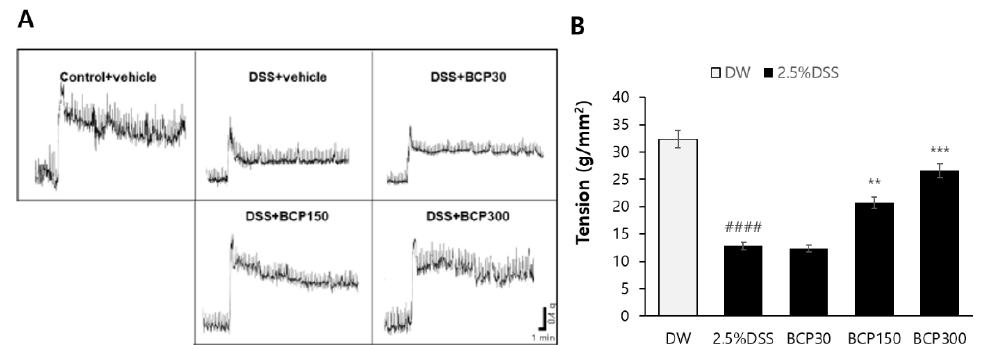
Figure 2. The effect of BCP on the changes of the inotropic contractile force in DSS-induced colitis model. After colon collection, the inotropic contractile force of the colon was measured to compare the effect of BCP on intestinal motility during colitis. Data are presented as mean ± SEM. Group comparisons were performed using unpaired t -test with post-test (####, p < 0.0001, compared to vehicle-treated control mouse) (**, p < 0.01; ***, p < 0.001, compared to vehicle-treated, DSS-induced colitis mouse).